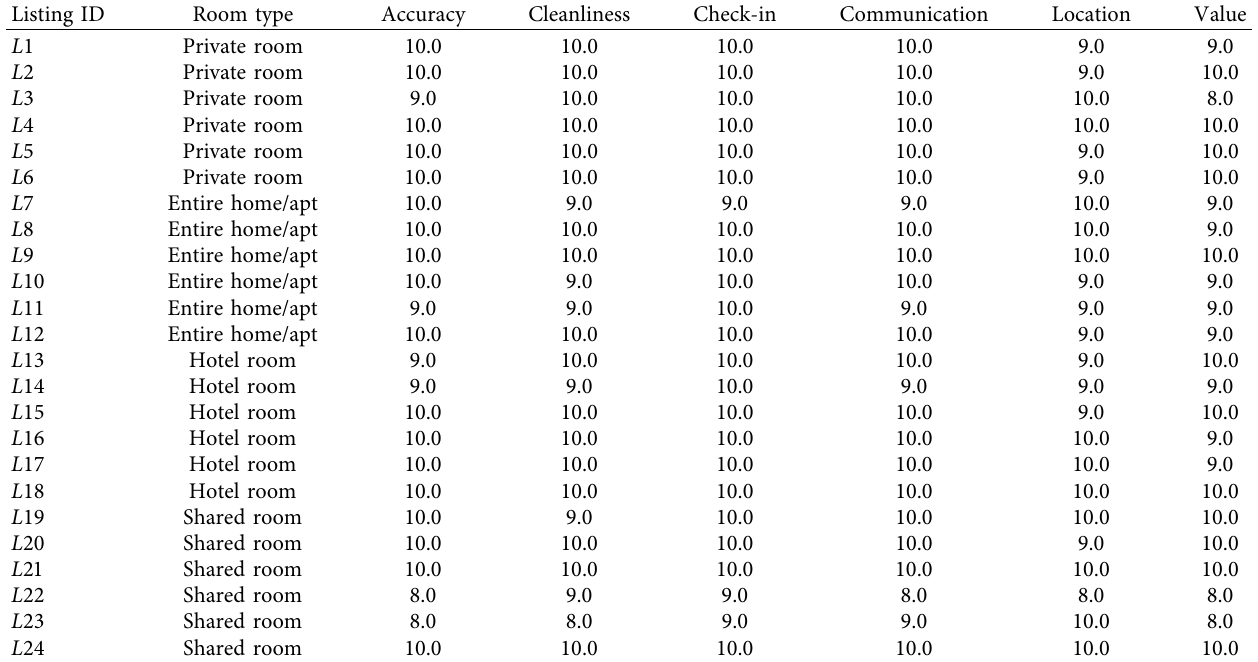
Table 3: Real scores by indicators attributed to a sample of 24 selected listings.